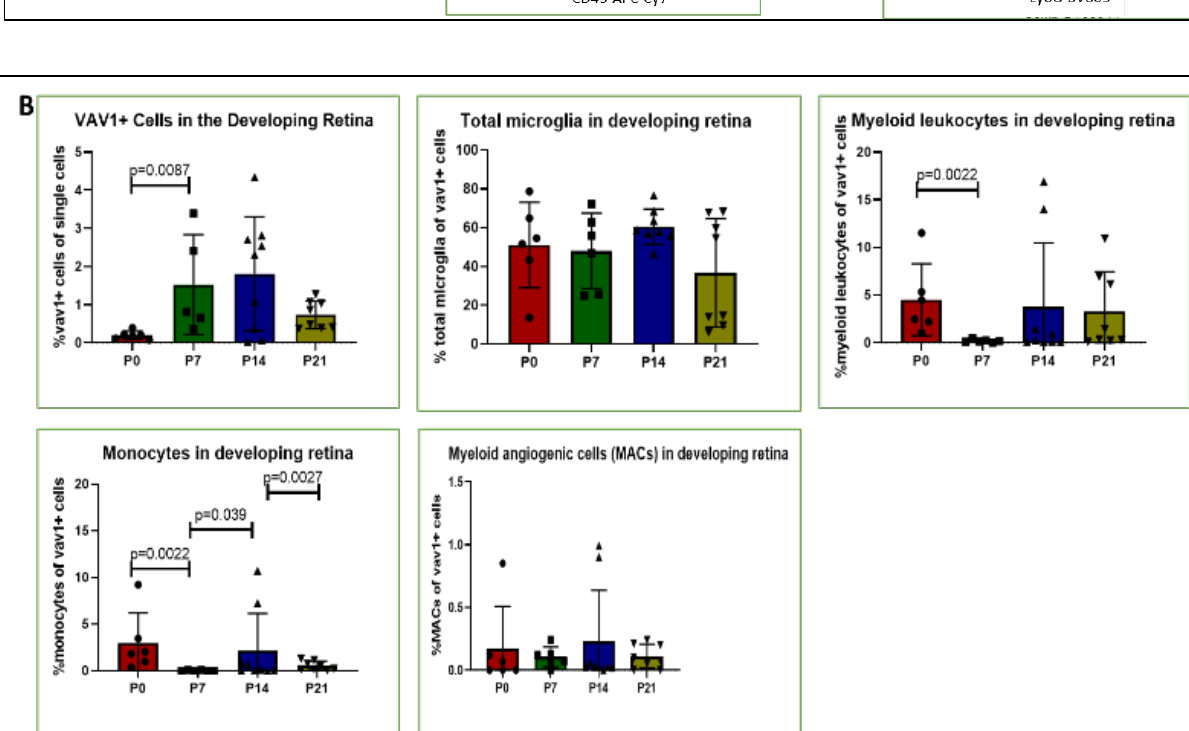
Figure 1. Hematopoietic cells in developing retina ( A ) . Representative plots showing flow cytometric analysis gates used to quantify cells within the retina. After gating for single cells, events were sub-gated into GFP + (Vav1) cells, GFP + /CD11b + /CD45 high myeloid leukocytes (ML), GFP + /CD11b + /CD45 low microglia and GFP + /CD11b + /CD45 - ‘primitive’ microglia. ML were sub-gated into Ly6C + Ly6G - monocytes, and CD31 + myeloid angiogenic cells (MACs). Panel ( B ) shows quantification for each of these populations at P0, P7, P14 and P21 as indicated.